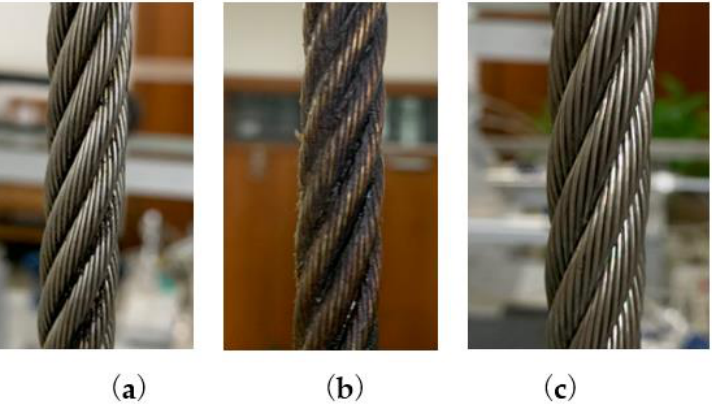
Figure 12. The sluice wire rope under three different working conditions: ( a ) ϕ 10 mm, without grease; ( b ) ϕ 10 mm, with grease; ( c ) ϕ 14 mm, without grease. Table 2. The results of the climbing adaptability test of the robot. Experimental Conditions of the Wire Rope